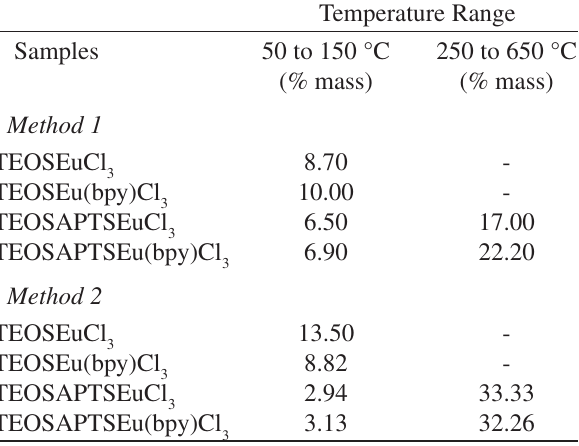
Table 1. Percentage loss of mass of the samples obtained by TGA